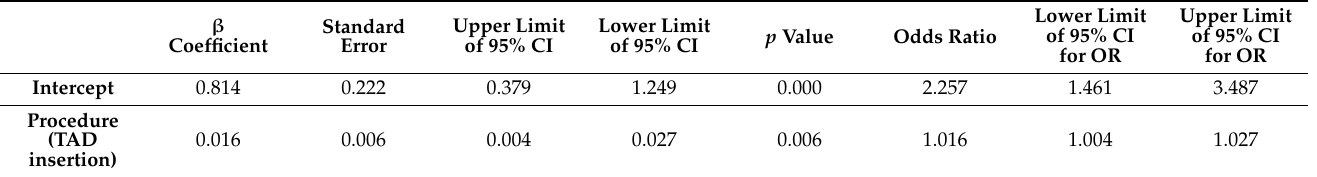
Table 2. Results of the logistic regression model.